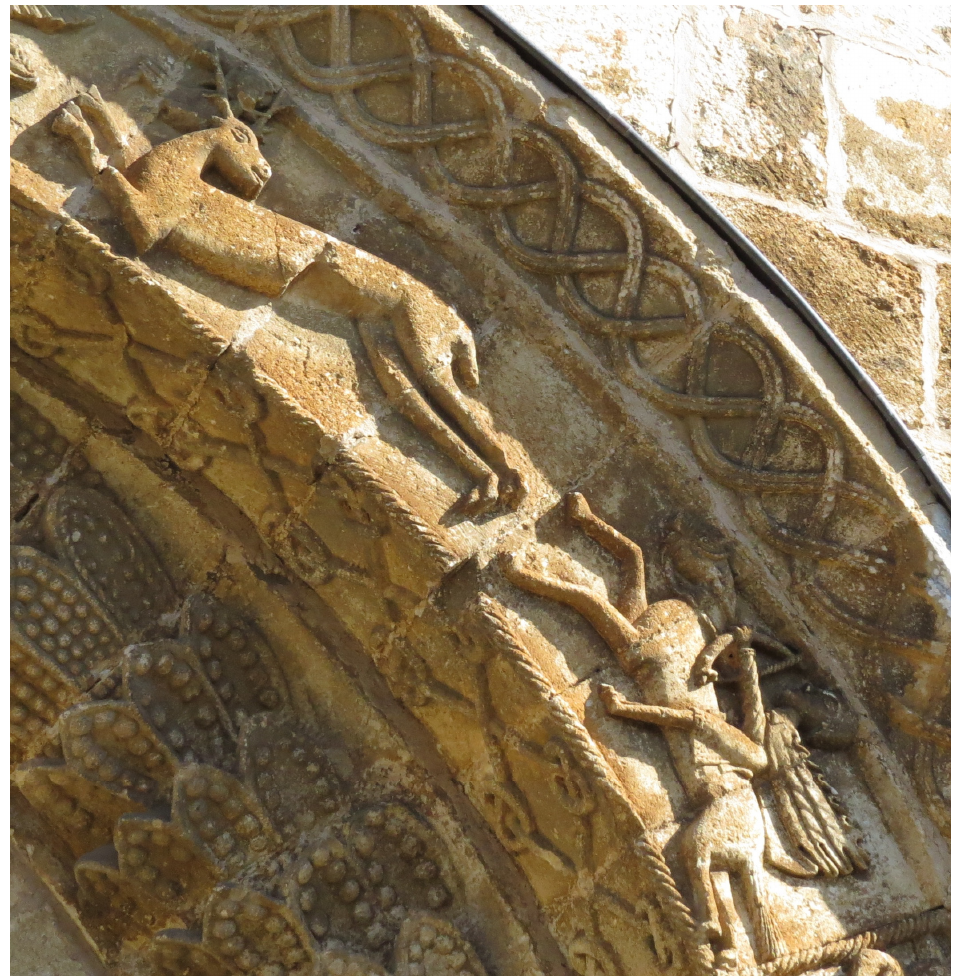
Figure 7. Saint-Eustace and the stag, detail of archivolt, west façade, Saint-Martin Church , 12th c., Besse, Dordogne, Nouvelle-Aquitaine, France. ©Author.